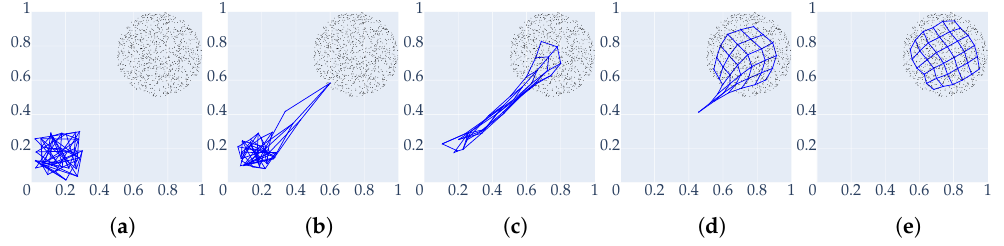
Figure 6. Evolution of a 6 × 6 × 1 ACSOM network during training over 5000 input vectors, with neurons shown as blue dots, neuronal connections represented as blue lines and input population shown as black dots. ( a ) t = 0. ( b ) t = 10. ( c ) t = 100. ( d ) t = 1000. ( e ) t =